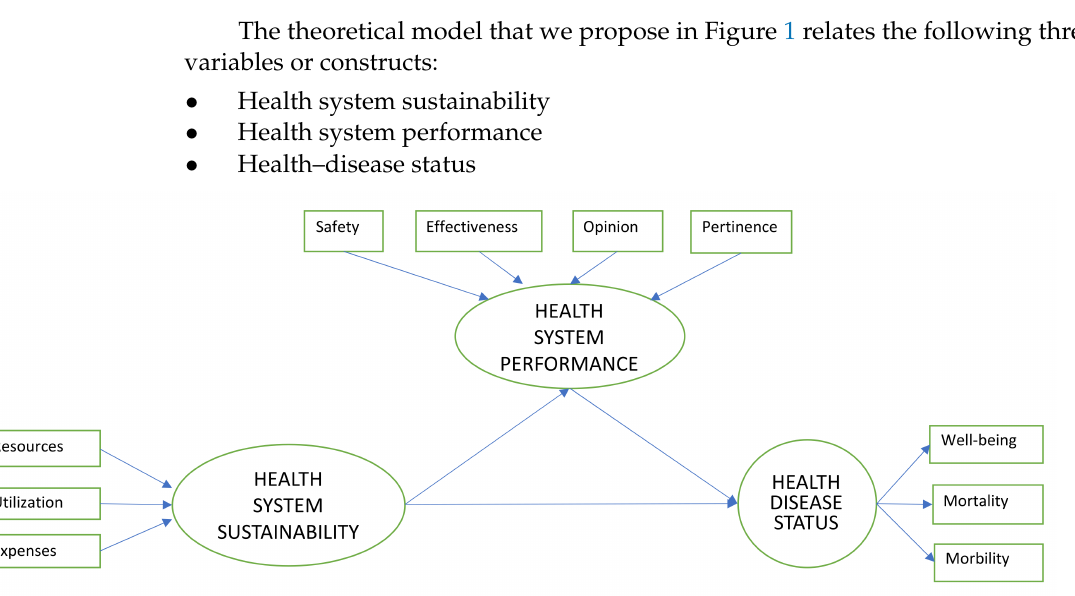
Figure 1. The theoretical model of health–disease status in